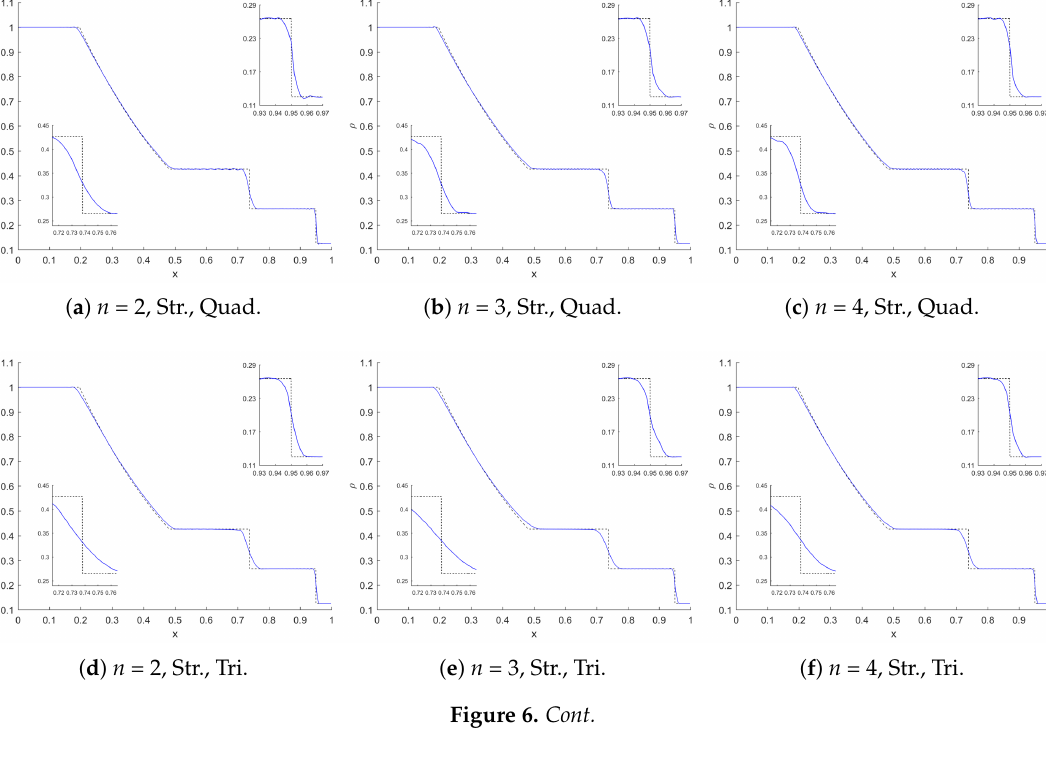
( d ) n = 2, Str., Tri. ( e ) n = 3, Str., Tri.